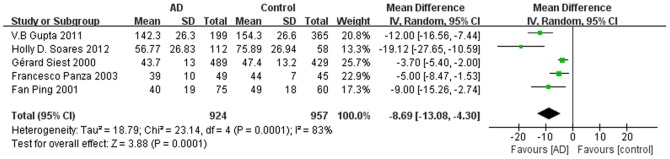
Forest plots for ApoE levels in AD and healthy controls controlling for fasting.AD, Alzheimer’s disease; SD, standard deviation; CI, confidence interval.